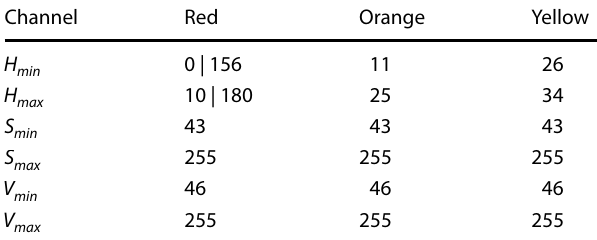
Fig. 5 Distribution of pixels in HSV space. a The lighting state of the vehicle lamp. b The lamp off state Table 1 HSV space color data Channel